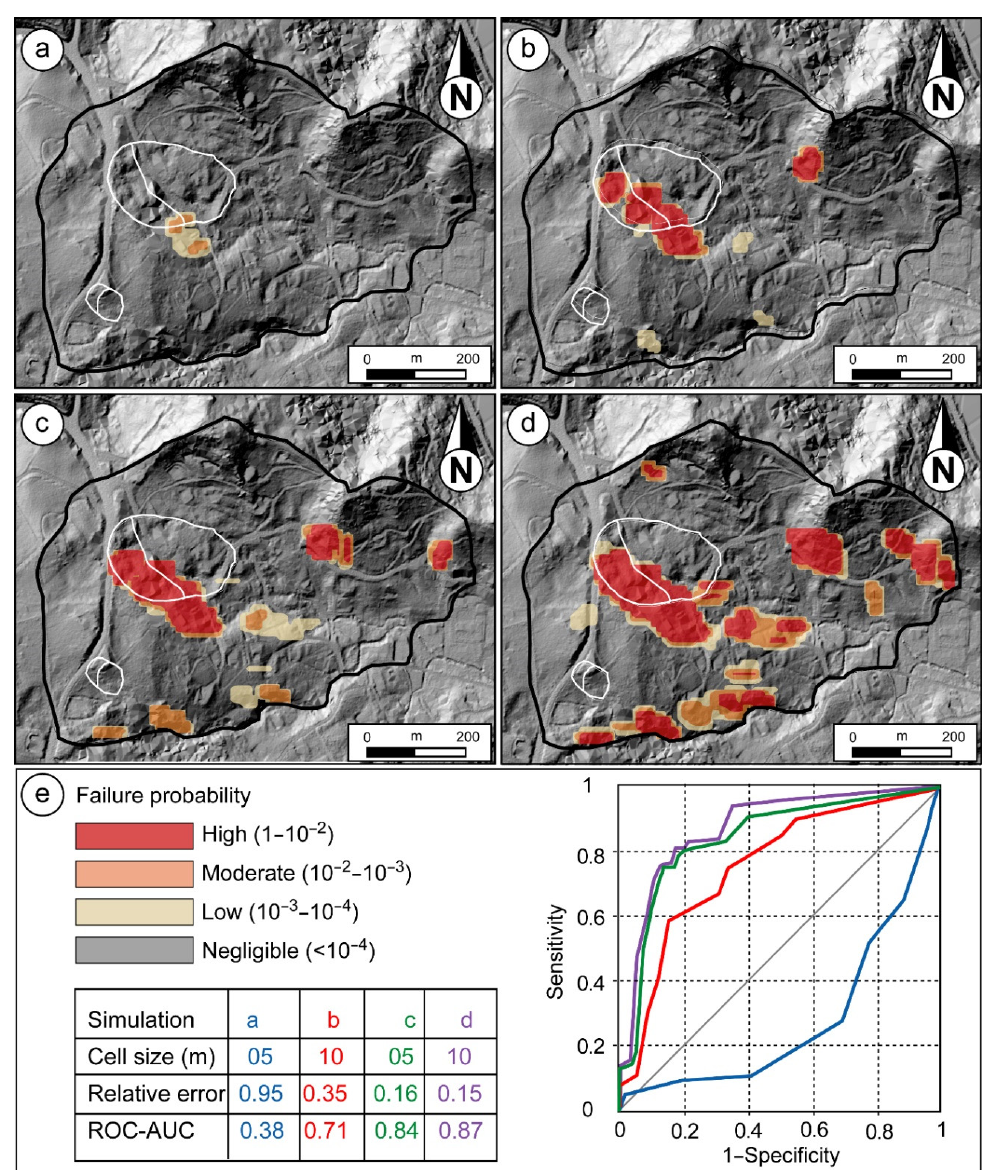
Figure 15. Influence of the type of materials introduced to compute failure probabilities with ALICE ® for the Morne-Figue area. ( a ) Map computed with a GWL = 0.5; ( b ) map computed with a GWL = 0.7; ( c ) map computed with a GWL = 0.8; ( d ) map computed with a GWL = 1; ( e ) statistical tests for the four computed maps. Hillshade maps were produced with the Litto3D DTM (IGN, 2010).